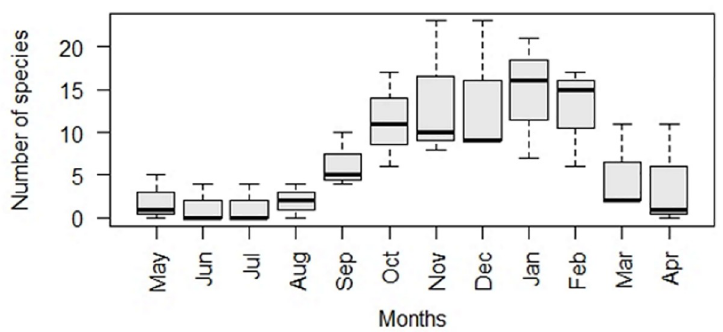
Fig 2. Numbers of woody plant species containing resources (flowers, new fruit/pods and new leaves) for the study period.